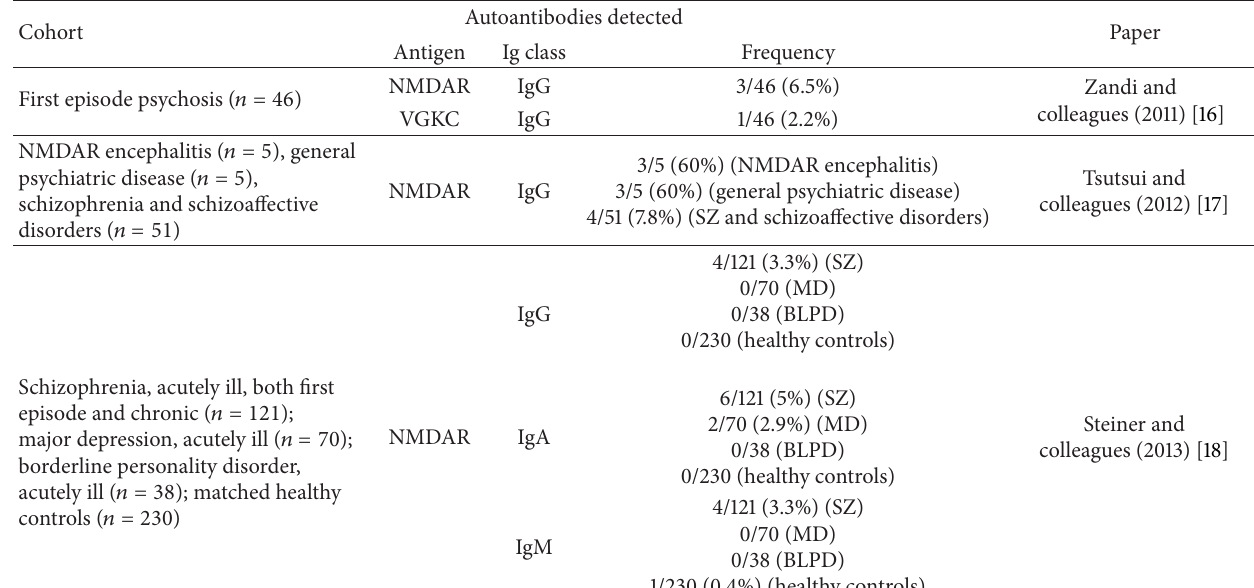
Table 2: Frequency of antibody detection in patients with